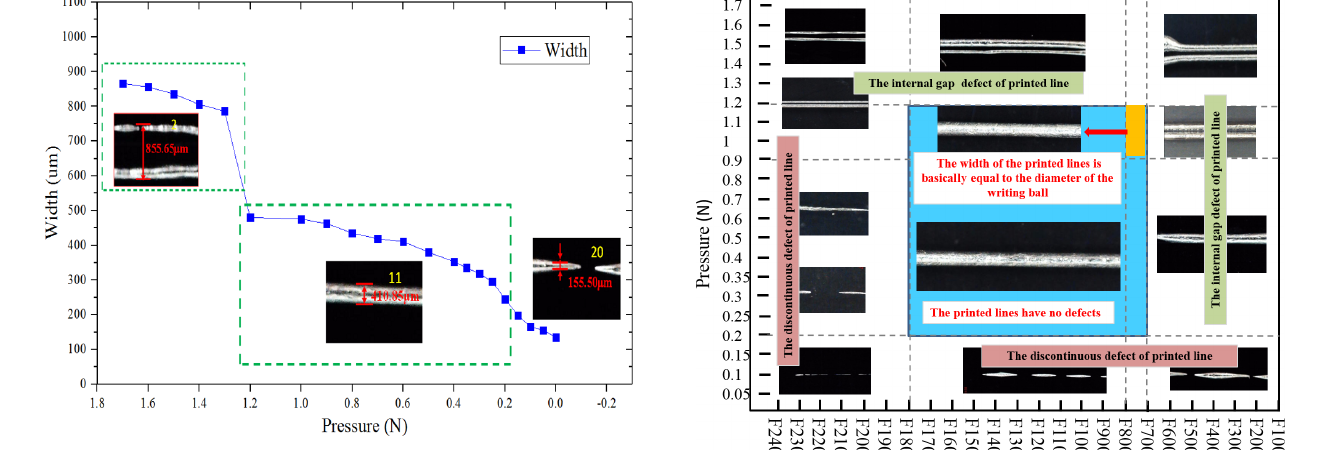
Figure 8. The width of printed lines with different writing pres- sures.